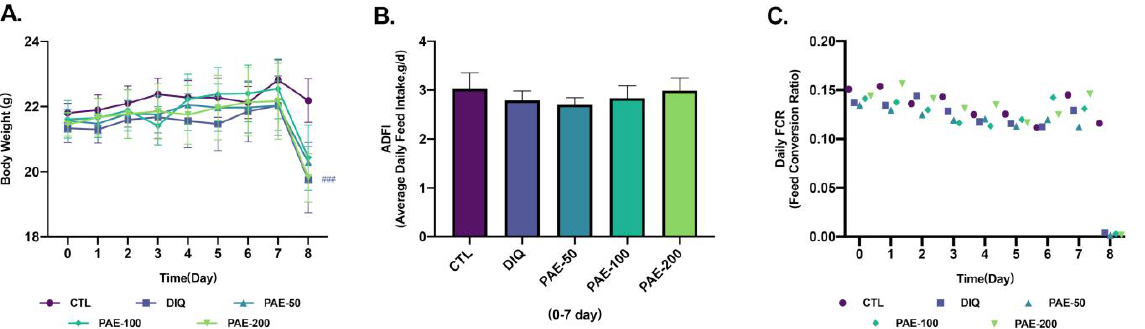
Figure 2. Effects of PAE on growth in diquat-induced mice: ( A ) Changes in body weight of mice ( n = 8); ( B ) effects of PAE on average daily feed intake (ADFI) in diquat-treated mice ( n = 8); ( C ) effects of PAE on daily feed conversion ratio (FCR) in diquat-treated mice ( n = 8). ### p < 0.001 as compared with the CTL group.